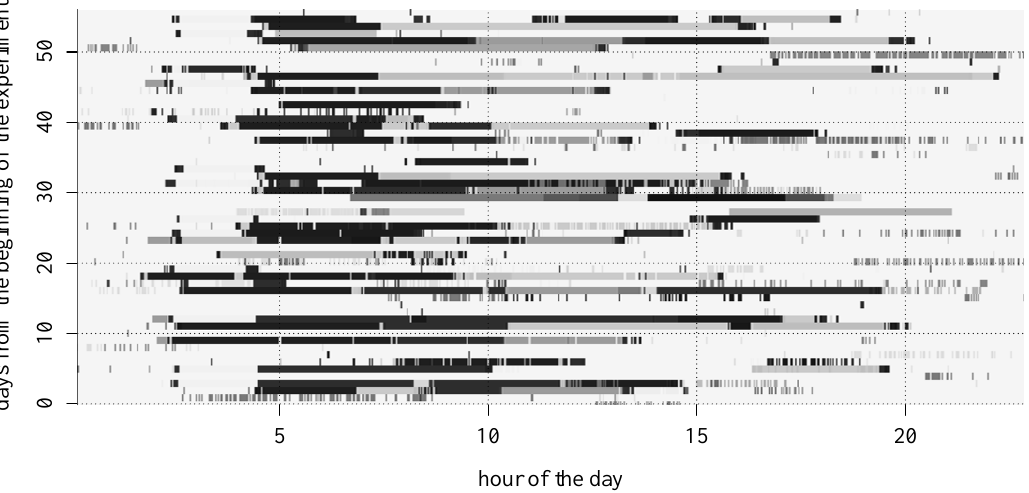
Figure 4. Visualization of a subject’s ST trajectories where blocks of the same gray level indicate the visits to the same place and white backgrounds represent unknown